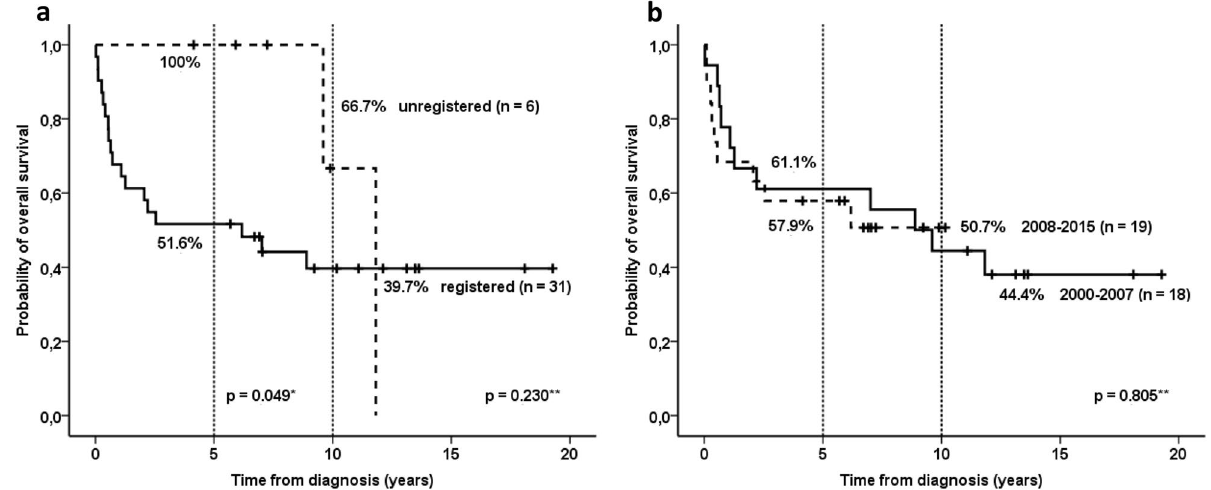
Figure 2. Probability of overall survival according to registration status ( a ) and treatment period ( b ). *Log-rank test for data censored at 5 years; **Log-rank test for data censored at the last follow-up. The survival probabilities were calculated using IBM SPSS Statistics 27.0 (https:// www. ibm. com/ partn erwor ld/ bpdir ectory/ partn er/ 6q81h/ insig ht- solut ions/